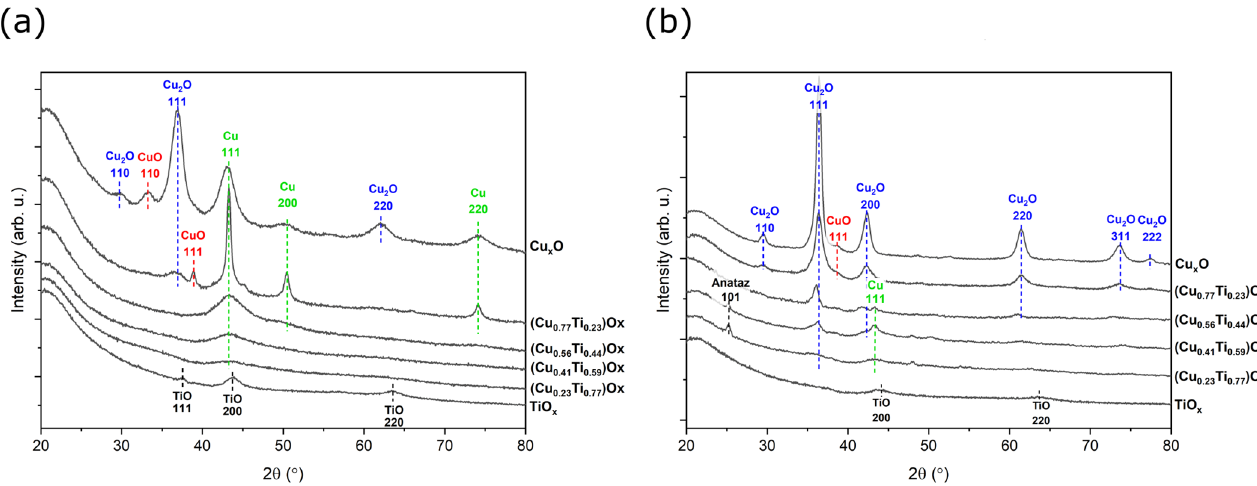
Figure 4. X-ray diffraction patterns of ( a ) as-deposited and ( b ) annealed at 473 K (CuTi)Ox thin